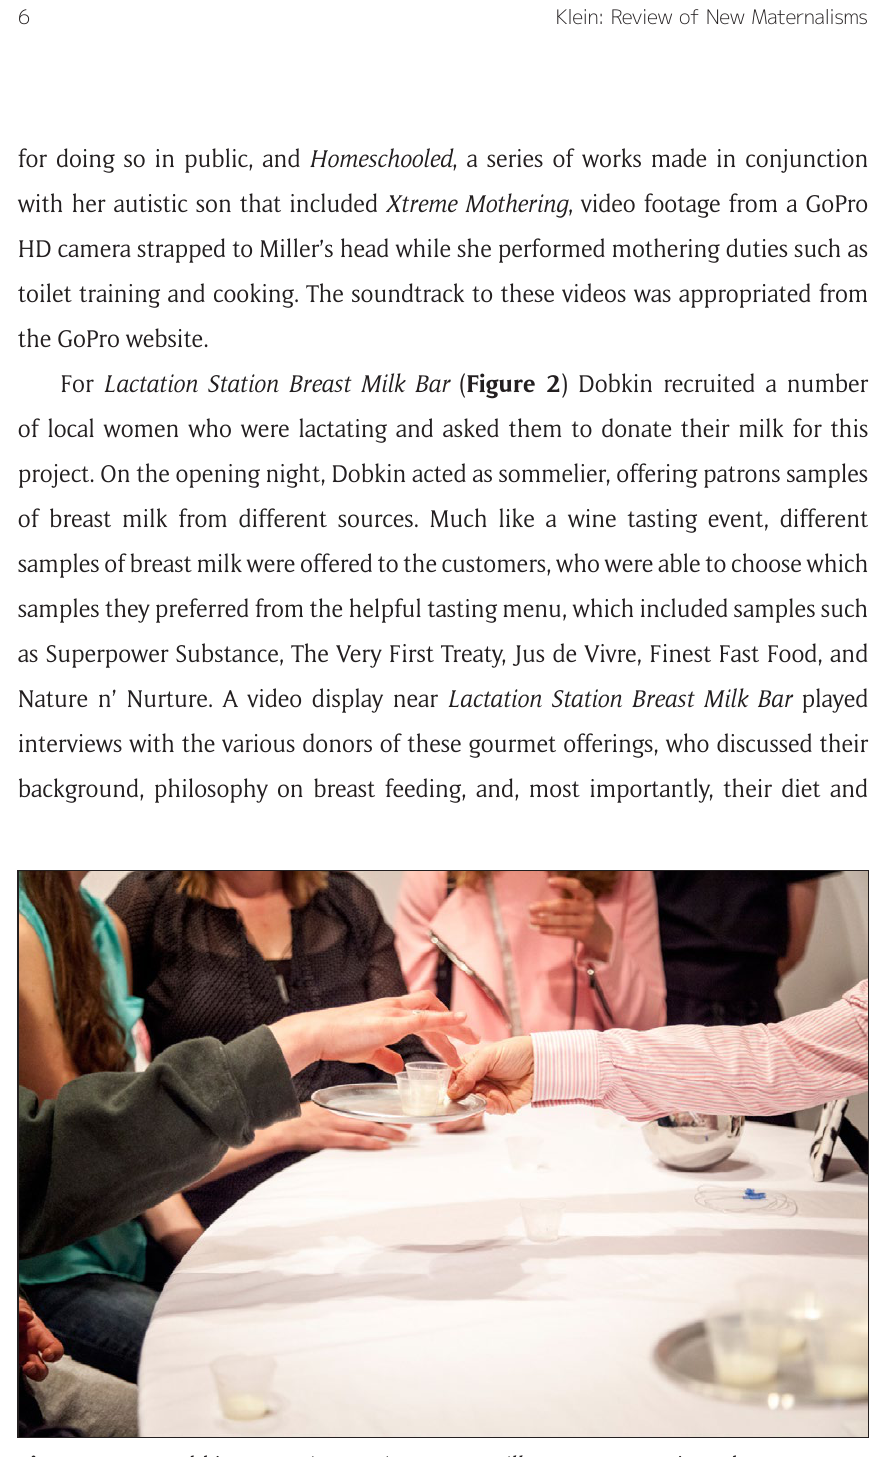
Figure 2: Jess Dobkin. Lactation Station Breast Milk Bar 2016 ongoing. Photo courtesy of Michael